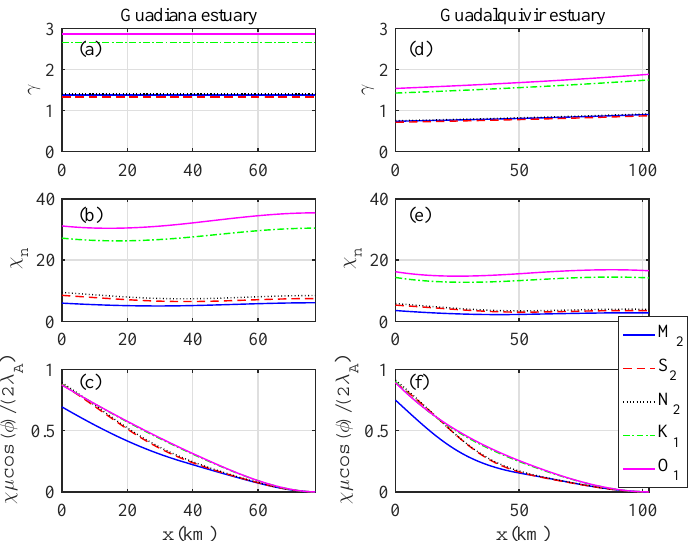
Figure 10. Longitudinal variations in estuary shape number γ (a, d) , friction number χ n (b, e) and χ n µ cos (φ)/( 2 λ A ) (c, f) in the Guadiana estuary (a–c) and Guadalquivir estuary (d–f) .